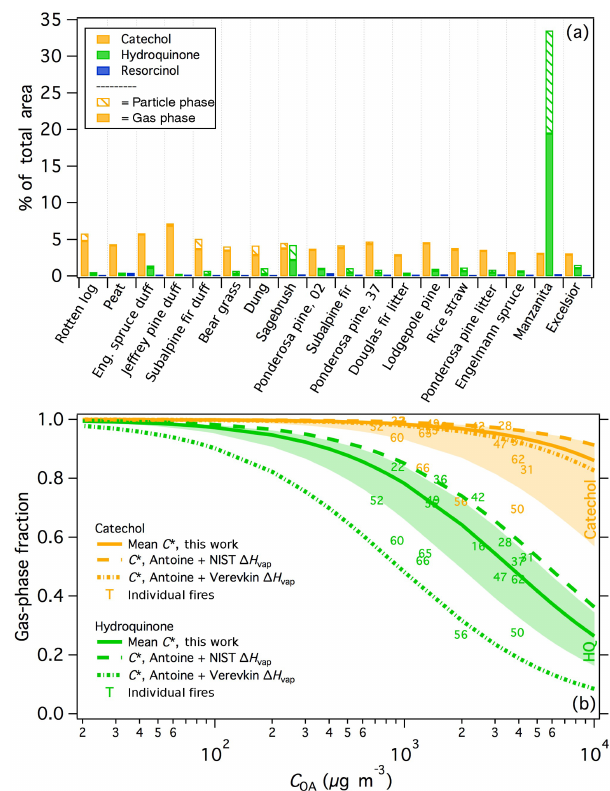
Figure 5. (a) The percentage of the total (SPE + PTFE) peak area attributed to benzenediol isomers for each fire. Samples are ar- ranged with increasing modified combustion efficiency (MCE) left to right. Fire numbers are indicated for the two ponderosa pine burns. (b) Calculated partitioning of catechol and hydroquinone (HQ) as a function of organic aerosol concentration ( C OA ). Solid lines indicate the partitioning based on the mean C ∗ values calcu- lated in this work, with the shaded areas indicating plus/minus one standard deviation of the mean C ∗ . Dashed lines represent the par- titioning calculated from vapor pressures estimated using Antoine coefficients and scaled to ambient temperature using (cid:49)H vap data from NIST (Burgess, 2018) and Verevkin and Kozlova